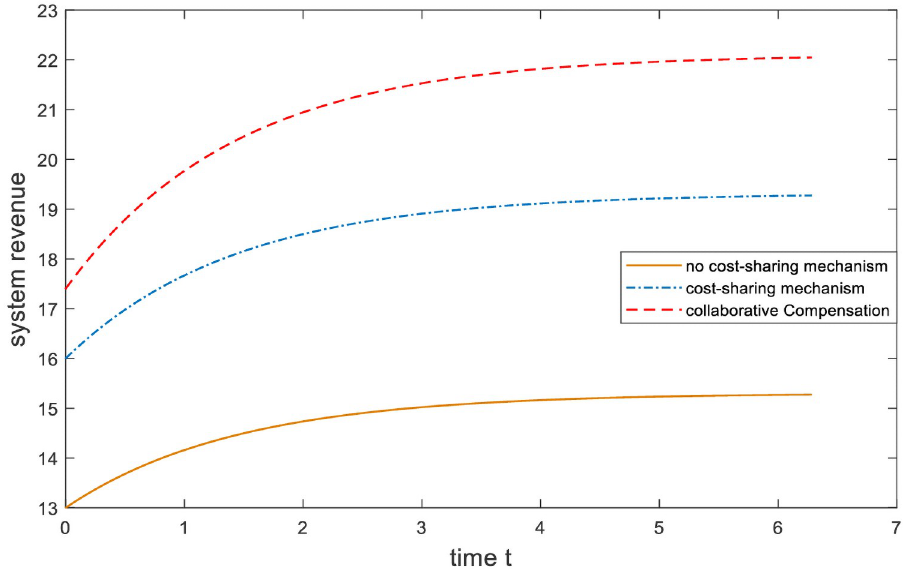
Fig 6. Comparison of system benefits under different